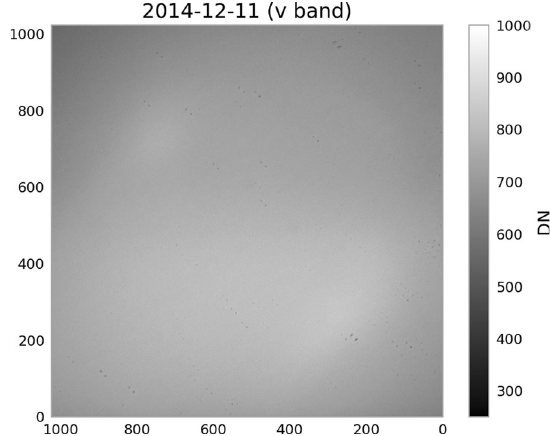
Fig. 1 FF-lamp image taken with the ONC-T v band in December